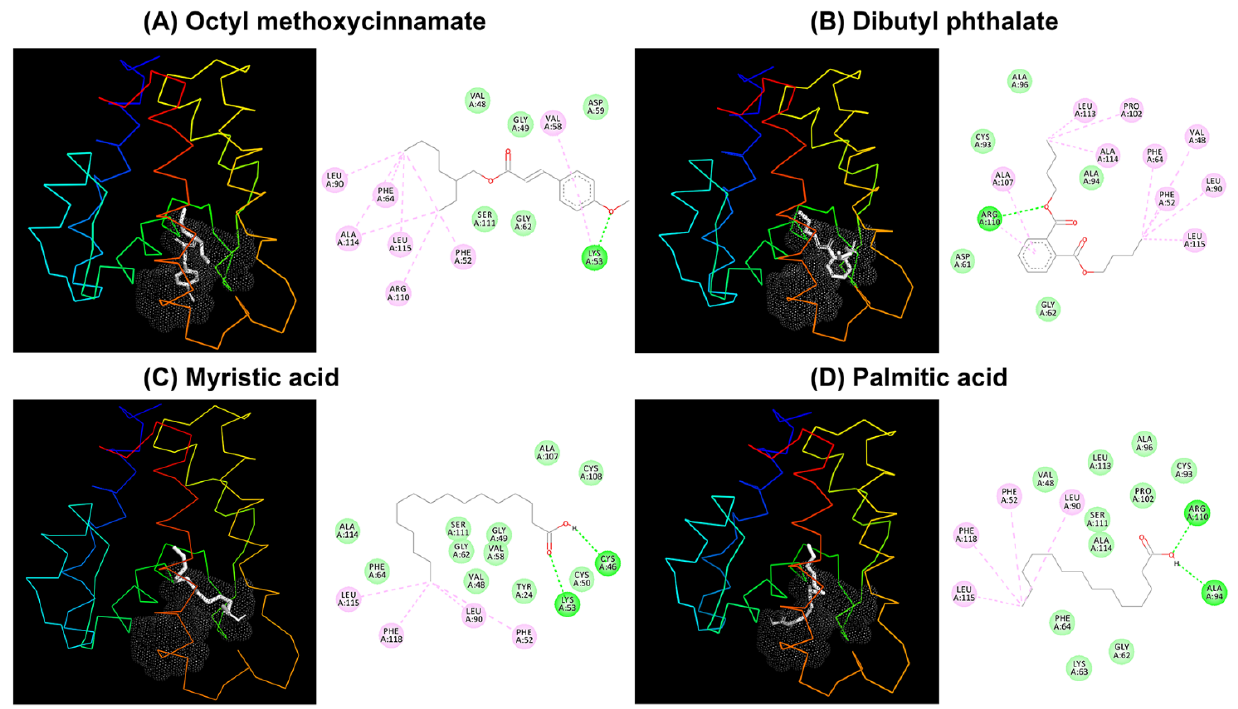
Figure 7. Molecular docking of TrufOBP4 with ligands. ( A ) 3D predicted interaction view of binding pocket (left) and 2D predicted interaction (right) of TrufOBP4 and octyl methoxycinnamate. ( B ) 3D predicted interaction view of binding pocket (left) and 2D predicted interaction (right) of TrufOBP4 and dibutyl phthalate. ( C ) 3D predicted interaction view of binding pocket (left) and 2D predicted interaction (right) of TrufOBP4 and myristic acid. ( D ) 3D predicted interaction view of binding pocket (left) and 2D predicted interaction (right) of TrufOBP4 and palmitic acid.